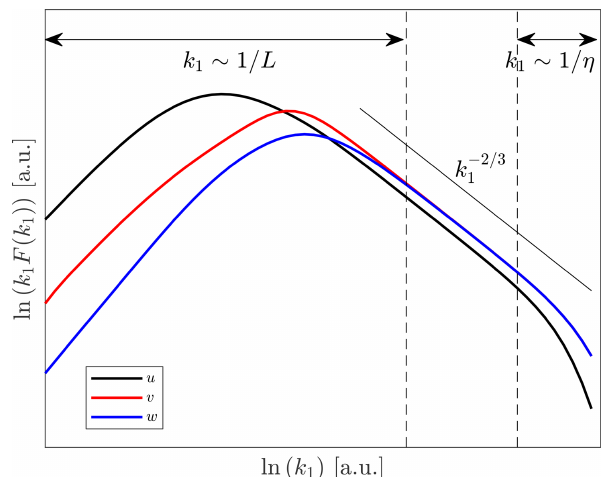
Figure 1. Idealized atmospheric velocity spectra showing the spec- tral regions and the relations in the inertial subrange (indicated within the vertical dashed lines). Notice that the spectra in the y axis are premultiplied by k 1 and so the spectral slope is − 2 / 3 instead of − 5 / 3 as in Eq.